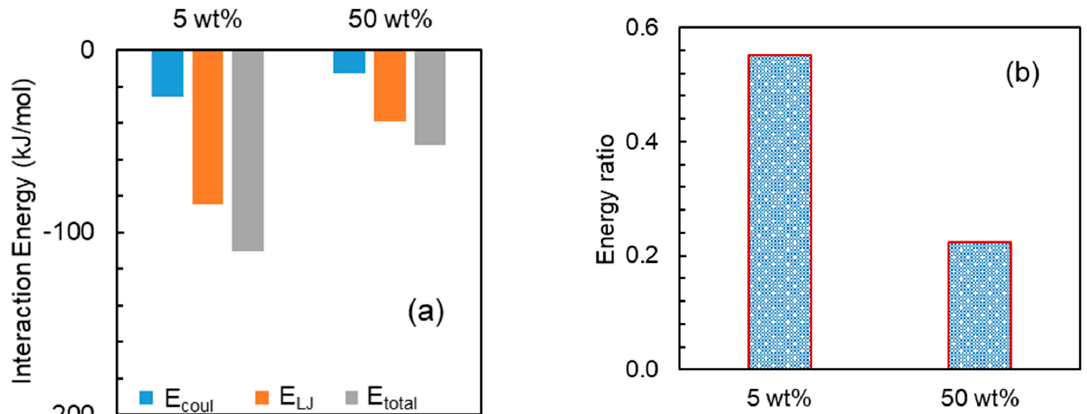
Figure 10. ( a ) Interaction energies between DMF and HPMC(AS) and ( b ) energy ratio: DMF– HPMC(AS)/DMF–DMF at 5 and 50 wt% DMF. HPMC(AS)/DMF–DMF at 5 and 50 wt% DMF.